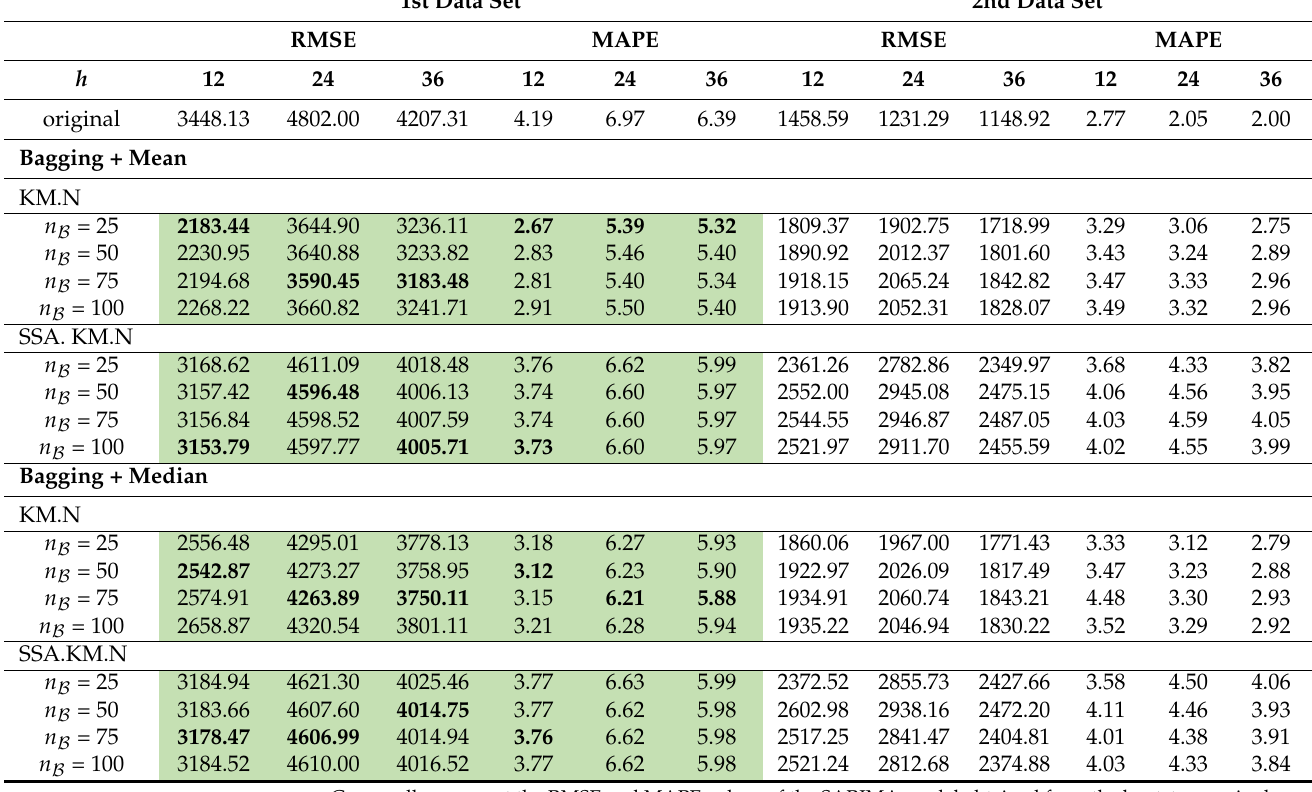
Table 6. RMSE and MAPE of h -step ahead forecast obtained by DSHW model from the original series, KM.N and SSA.KM.N bootstrap series. 1st Data